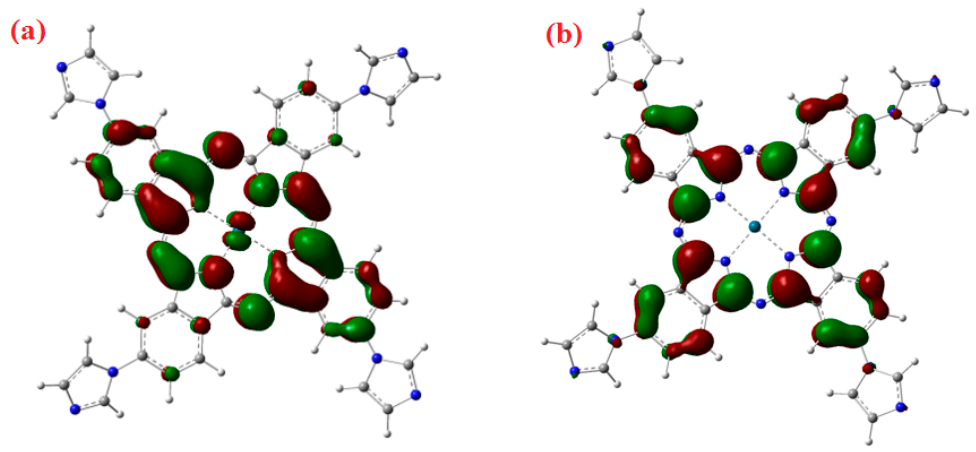
Figure 3. Virtual ( a ) LUMO and ( b ) HOMO orbital frontiers of PdPc molecule, the theoretical energy gap is 2.26 eV.